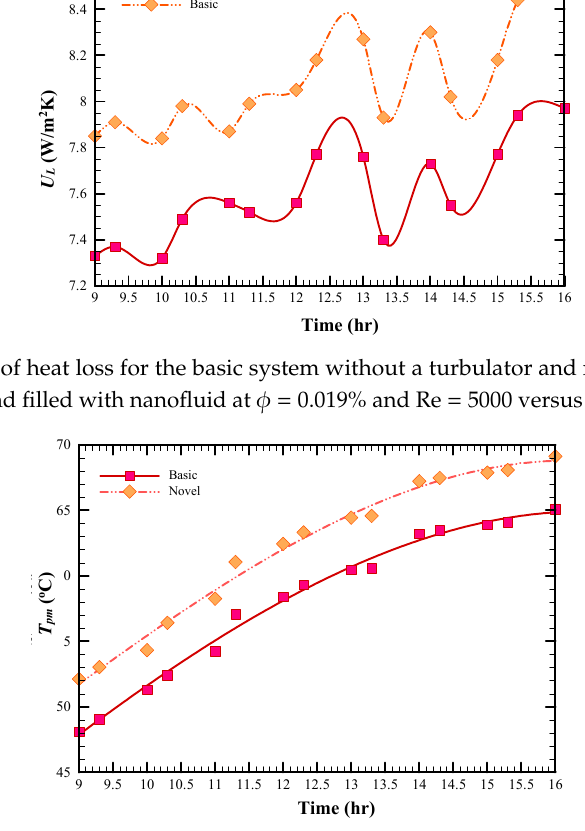
Figure 8. Variation of absorber plate temperature for a basic system without a turbulator and novel PTSC equipped with a turbulator and filled with nanofluid at ϕ = 0.019% and Re = 5000 versus different times of day.